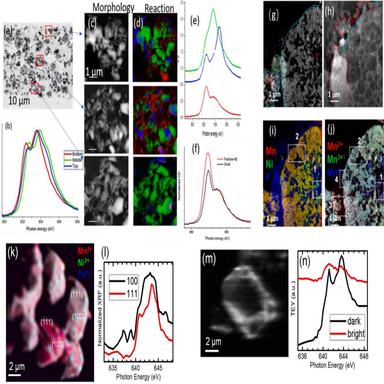
.1. (a) Morphology mapping of the self-discharged fully delithiated LNMO electrode thin-section; (b) Ni L-edge XANES; (c) morphology; (d) chemical map (Ni2+-like shown as red, Ni3+-like shown as green and Ni4+-like shown as blue) of the top, middle and bottom selected regions of the LNMO electrode in a) by SVD fitting of the Ni L3-edge STXM image stack, using the internal fitting references displayed in (e); (f) Ni2+ L-edge comparison. Adapted from the literature with permission; (g) Ptychogra